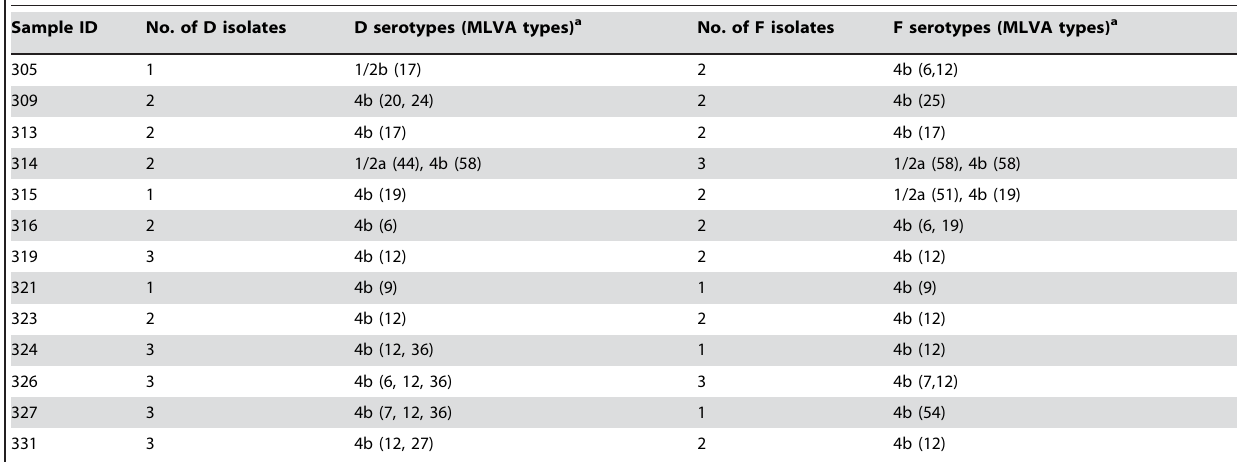
Sample ID No. of D